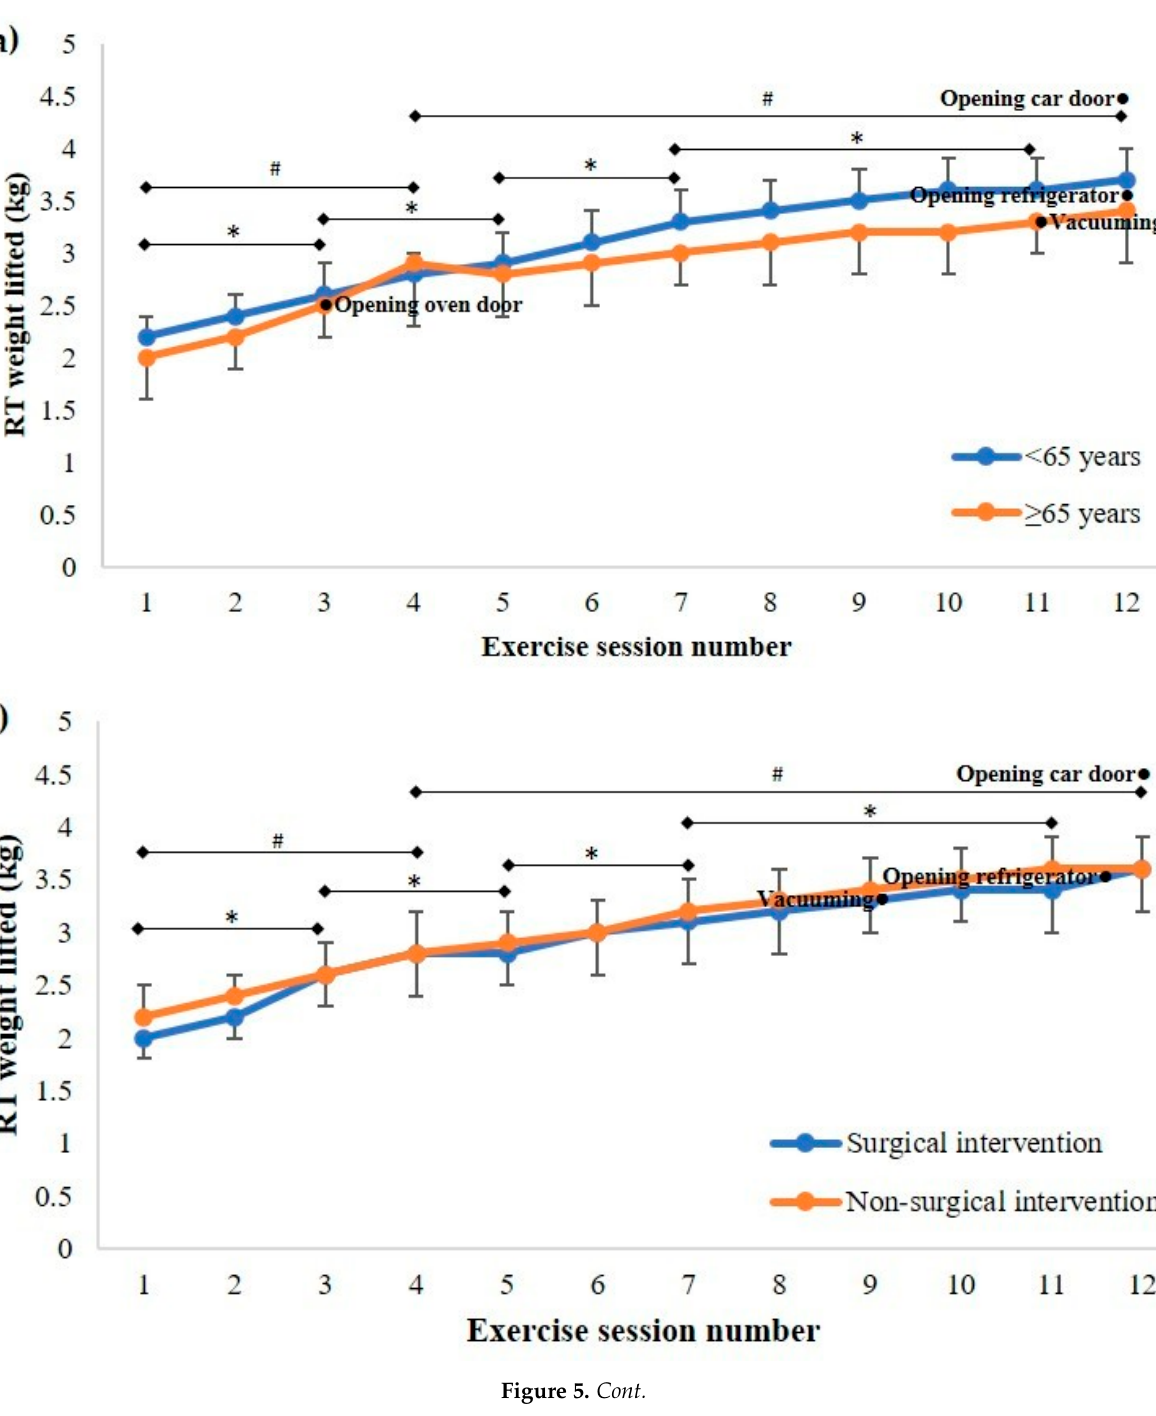
Figure 5. Comparison of resistance training (RT) weight lifted during cardiac rehabilitation with work required for activities of daily living, with patients categorised by ( a ) age; ( b ) cardiovascular intervention; and ( c ) initial grip strength tertile. Data presented as mean (95% CI). * Significant progression in weight lifted for ( a ) <65 years; ( b ) non-surgical intervention; and ( c ) high physical capacity. # Significant progression in weight lifted for ( a ) ≥ 65 years; ( b ) surgical intervention; and ( c ) moderate physical capacity. ^ Significant progression in weight lifted for ( c ) low physical capacity.